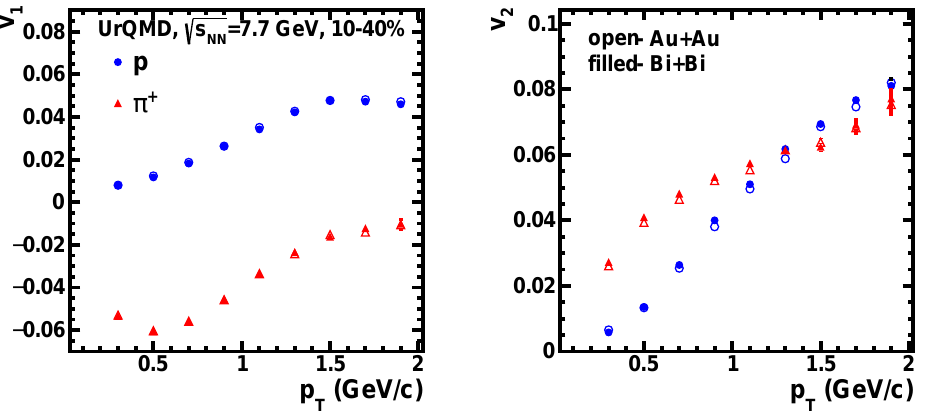
Figure 14. p T dependence of directed v 1 flow ( left panel) and elliptic flow v 2 ( right panel) of charged pions and protons for 10–40% central heavy-ion collisions at represent results for Au + Au and closed symbols for Bi + Bi